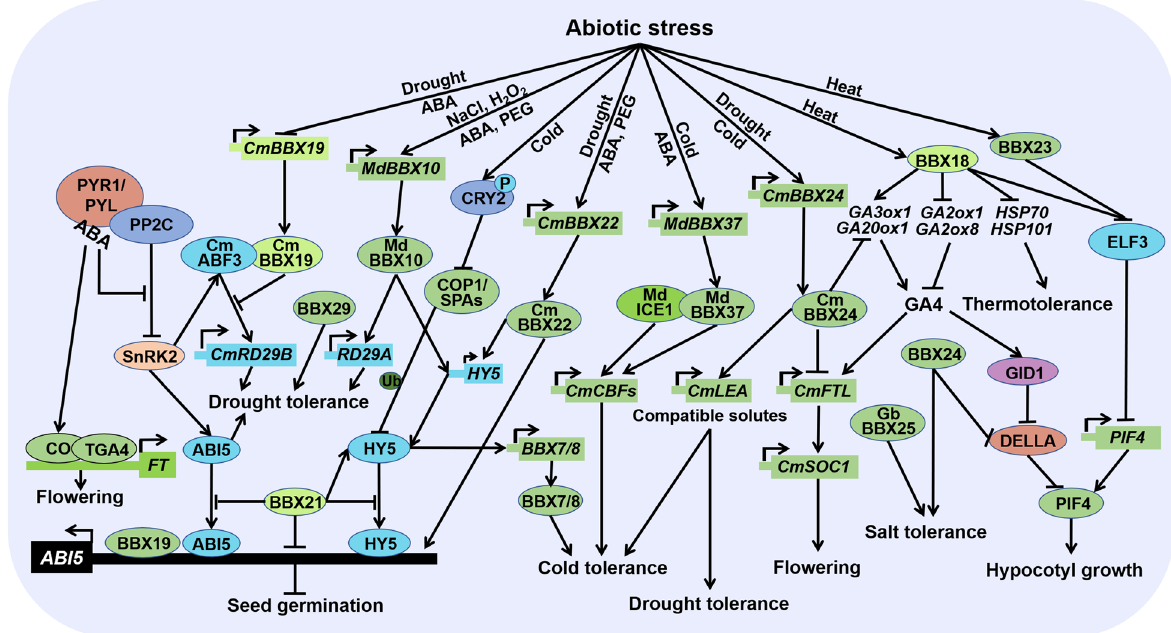
Fig. 6 BBX proteins in abiotic stress response. BBX proteins play critical roles in abiotic stress. Drought and ABA repress the expression of CmBBX19 , whose protein interacts with CmABF3 to inhibits its transcriptional activity, contributing to suppress drought tolerance. The expression of MdBBX10 is significantly induced by NaCl, H 2 O 2 , polyethylene glycol (PEG) and exogenous ABA. MdBBX10 improves drought tolerance possibly through increasing ABA responsive genes including RD29A and HY5 . Cold promotes the accumulation of phosphorylated CRY2 which completely interacts with COP1 to release HY5. The accumulated HY5 directly binds to the promoter of BBX7 and BBX8 , leading to enhance cold tolerance. Drought, PEG and ABA upregulate the expression of CmBBX22 , which in turn increases the transcription of HY5 and ABI5 , improving drought tolerance. The expression of MdBBX37 is rapidly increased in response to cold and ABA treatments. MdBBX37 binds to the promoter of MdCBFs to activate their transcription, as well as interacts with MdICE1 to enhance the transcriptional activity of MdICE1 on MdCBF1 , resulting in promoting cold tolerance. Drought and cold stimulate the expression of CmBBX24. The accumulated CmBBX24 positively regulate genes related to compatible solutes and carbohydrate metabolism to strength tolerance to drought and cold stress, but negatively regulate GA biosynthesis to delay flowering. Heat elevates the transcript and protein level of BBX18 and BBX23 which reduce the protein accumulation of ELF3, releasing the PIF4-mediated hypocotyl growth in thermomorphogenesis. However, BBX18 downregulates the expression of HSP70 and HSP101, leading to weaken thermotolerance. BBX21 negatively regulates dehydration response, while BBX29 augments drought tolerance in sugarcane. BBX24 and GbBBX25 are involved in strengthening salt